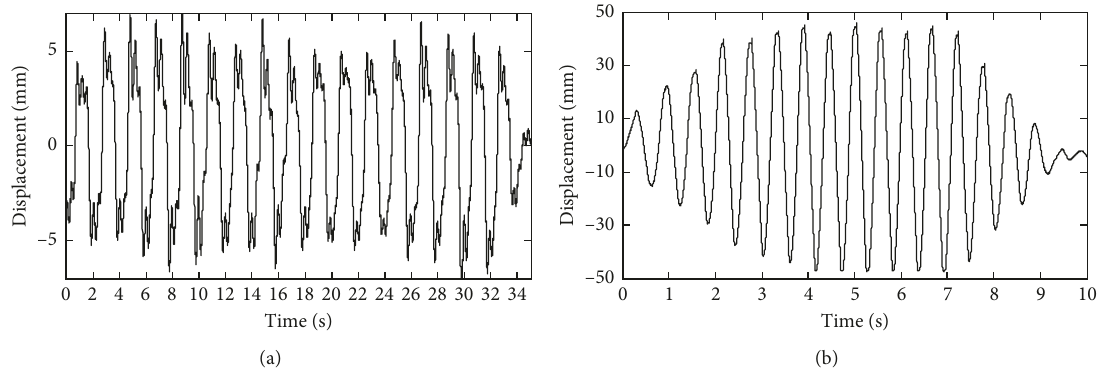
Figure 7: The structural lateral displacement of twenty persons swaying at (a) 1.0 Hz and (b)